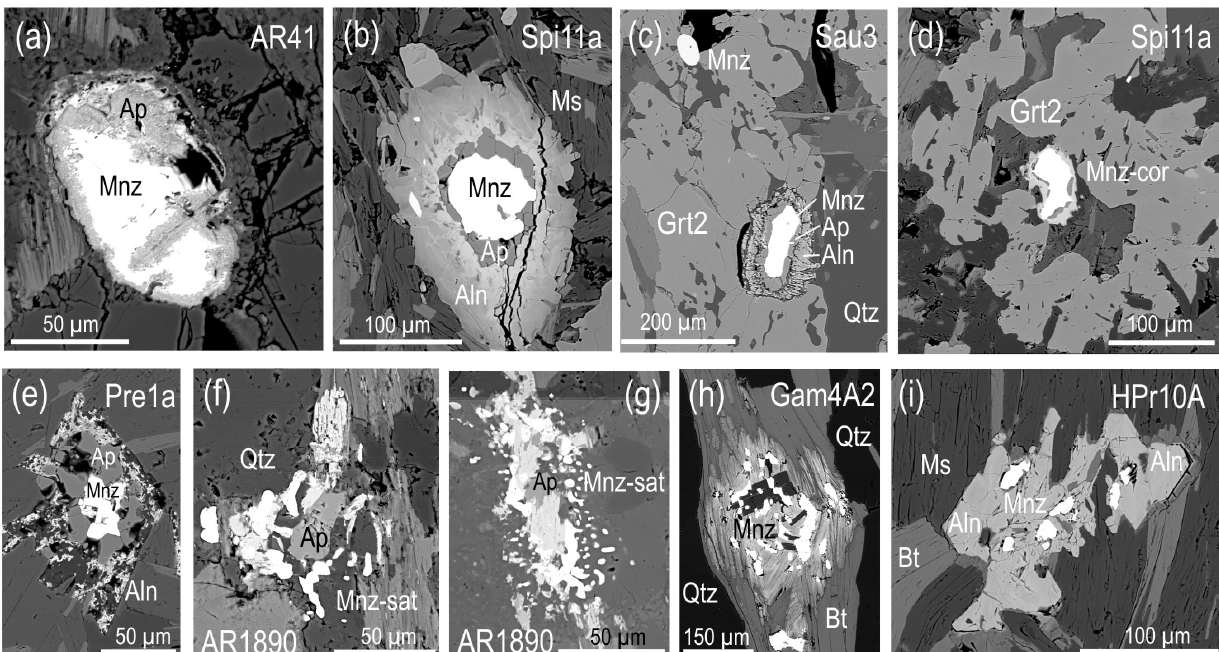
Figure 2. Microstructures of monazite in backscattered electron images (BSE). ( a ) Partial and graded decomposition of Carboniferous monazite (Mnz) to apatite (Ap) in the Aiguilles Rouges Massif. ( b ) Permian monazite with small apatite (Ap) and broad rim of allanite (Aln), initial stage of corona structure (Saualpe Micaschist Complex). ( c,d ) Corona structure around Permian monazite (Mnz-cor) enclosed in garnet (Grt) in contact to quartz (Qtz), suggesting a Cretaceous age of garnet (Saualpe Eclogite and Micaschist complexes). ( e ) Permian monazite with broad apatite rim and few tiny allanite crystals in the outer corona (Saualpe Preims Complex). ( f , g ) Monazite satellite microstructures (Mnz-sat) with Carboniferous ages around apatite in mylonitic garnet gneiss (Aiguilles Rouges Massif). ( h ) Cluster microstructure of Carboniferous monazite in biotite (Bt) in the Oetztal-Stubai Complex. ( i ) Cluster structure of Cretaceous monazite in allanite (BSTW, Prijakt Subgroup).